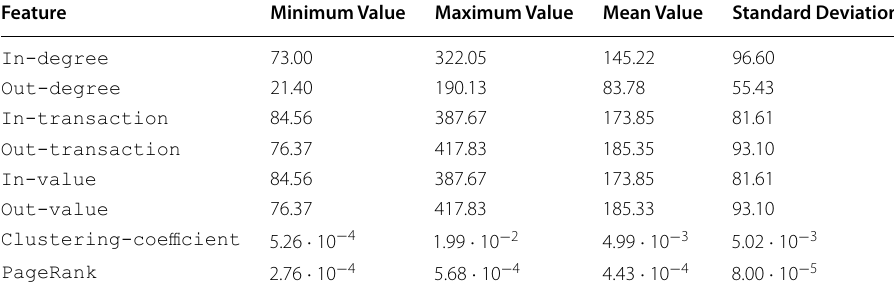
Table 5 Minimum, maximum, mean and standard deviation of the values of the spectrum features for the class “Exchange” Feature Minimum